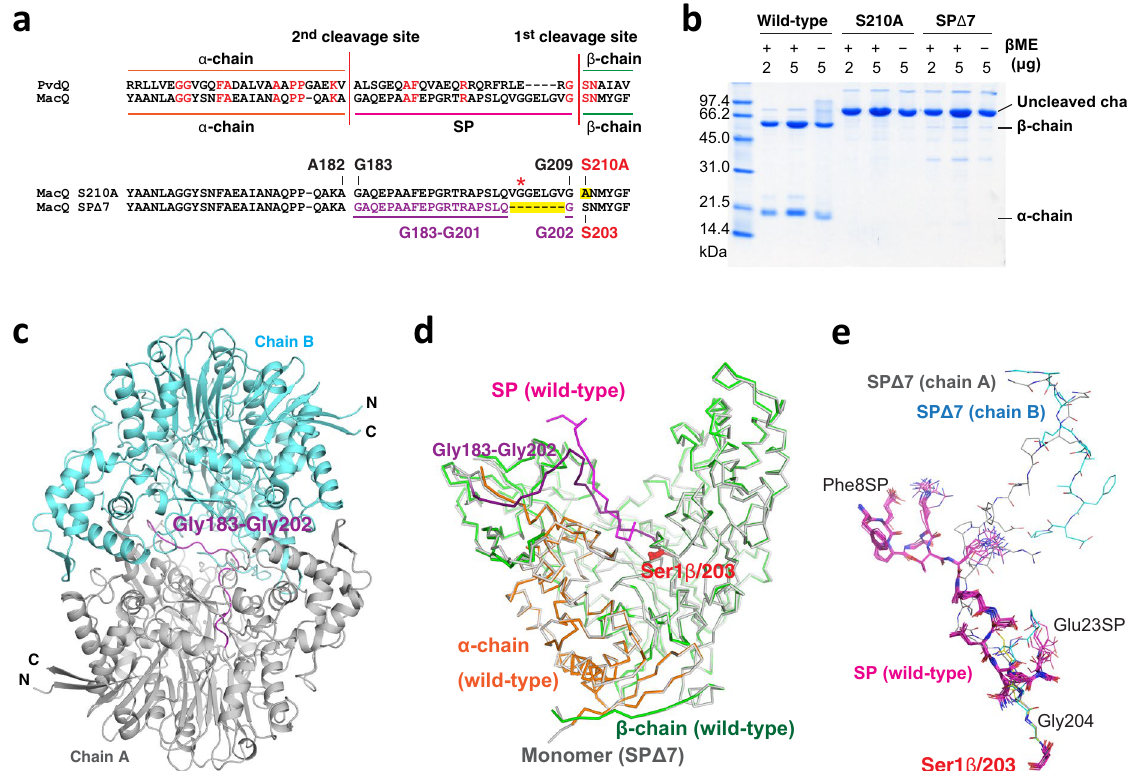
Figure 5. Mutational analyses of MacQ. ( a ) Cleavage site of MacQ and PvdQ and the amino acid sequence of S210A and SP Δ 7 mutants around SP region. Deletion or substitutions are highlighted in yellow. The Gly21SP (Gly203 in the uncleaved form), the nearest SP residue to the active site, is indicated by the red asterisk. The seven-residue deletion is the minimum requirements to delete the Gly21SP (Gly203) in the cleaved form of MacQ with keeping the cleavage sequence Gly209-Ser210. ( b ) SDS-PAGE analysis of wild-type MacQ and mutants S210A and SP Δ 7 under reducing ( β -mercaptoethanol ( β ME) + ) and non-reducing ( β ME − ) conditions. The results clearly show that both S210A and SP Δ 7 mutants were not cleaved. ( c ) Overall structure of MacQ SP Δ 7. The structure shows the same capsule-like molecule as that of wild-type MacQ, but consists of two uncleaved monomers. The residues 183–202, which correspond to the SP of the wild-type enzyme, are coloured in dark magenta. ( d ) Structure superimposition of wild-type MacQ heterodimer and SP Δ 7 monomer. The α -chain, SP, and β -chain of wild-type MacQ are coloured in orange, magenta, and green, respectively. The SP Δ 7 is coloured in gray, while the Gly183-Gly202 is coloured in dark magenta, as shown in (a). The conformation of the SP region of wild-type MacQ and the corresponding Gly183-Gly202 of SP Δ 7 is completely different. ( e ) Structure superimposition of the SP/Ser1 β of wild-type MacQ in ligand-free and C 10 /PAA complex and the Gly183-Ser203 of the SP Δ 7. A total of 12 chains for wild-type MacQ and 4 chains for SP Δ 7 are shown. The SP Δ 7 residues of 193–197 for chain B, 178–200 for chain C and 179–200 for chain D could not be built due to poor electron density. The carbon atoms are coloured in magenta for the SP of wild-type enzyme, and in gray for chain A, cyan for chain B, yellow for chain C, and light blue for chain D of the SP Δ